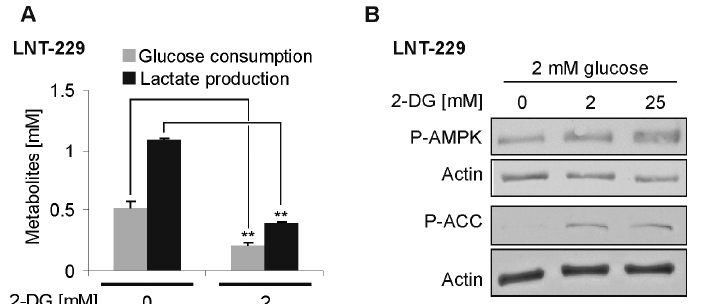
Figure 2. 2-deoxyglucose-mediated effects on glucose consumption and AMP-kinase signaling. ( A ) Human LNT-229 glioblastoma cells were incubated in serum-free Dulbecco’s modified eagle medium (DMEM) containing 2 mM glucose in the presence or absence of additional 2-DG for 6 h, as indicated. Glucose consumption and lactate production were measured in the supernatant ( n = 3, mean + standard deviation, ** p < 0.01, Student’s t -test). ( B ) LNT-229 cells were incubated as in ( A ), with different concentrations of 2-DG, as indicated. Cellular lysates were analyzed by immunoblot with antibodies for P-AMPK, phosphorylation target acetyl-CoA carboxylase (P-ACC), and actin. 2.2. Metabolic Alterations Induced by Ketogenic Diet in Athymic Mice (Foxn1nu)